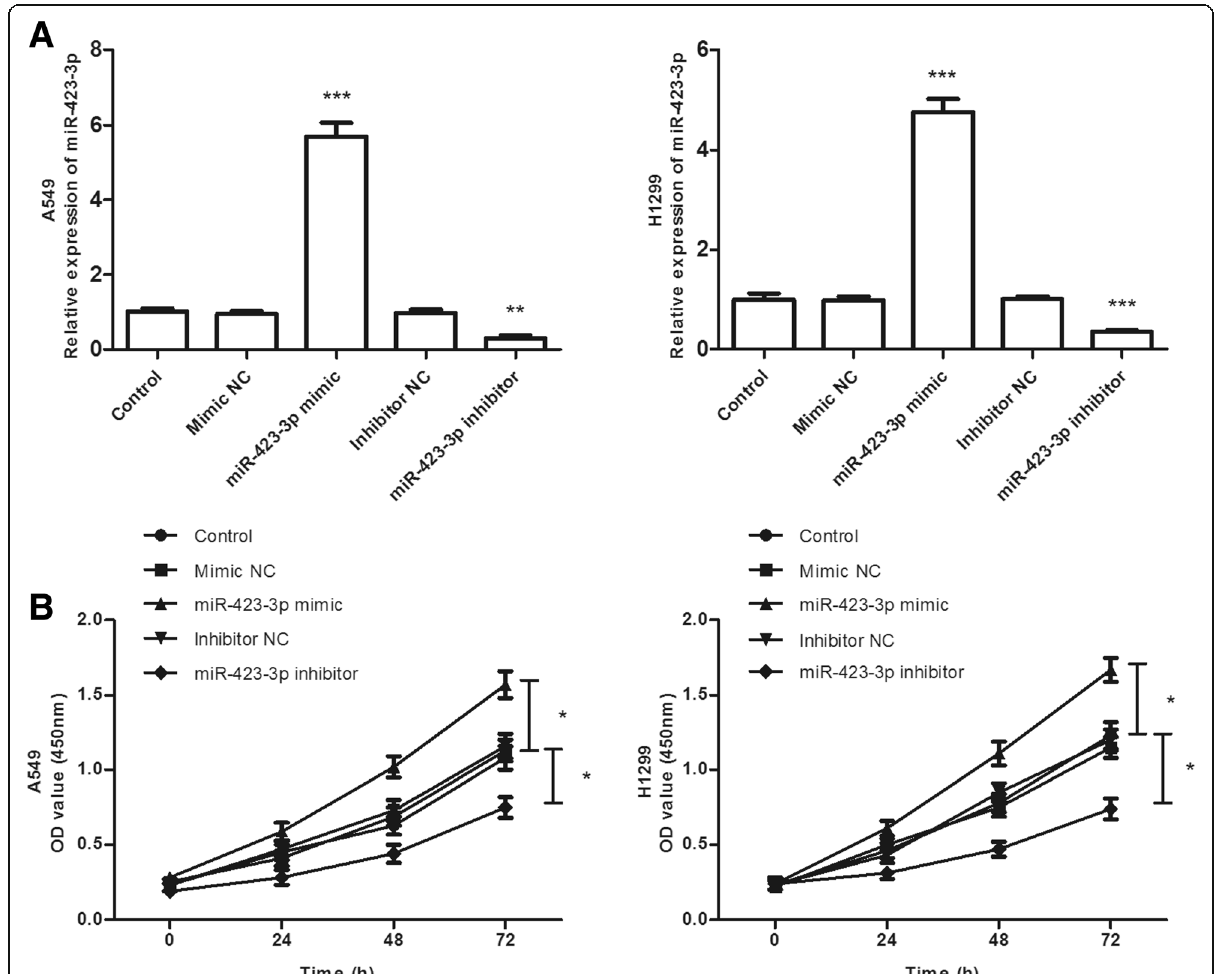
Fig. 3 Overexpression of miR-423-3p promotes cell proliferation, while inhibition of miR-423-3p suppresses cell proliferation of A549 and H1299 cells. a Expression of miR-423-3p in mimic NC, miR-423-3p mimic, inhibitor NC, or miR-423-3p inhibitor-transfected cells. (** P < 0.01, *** P < 0.001). b Effects of miR-423-3p on lung cancer cell proliferation in A549 and H1299 cells. (* P <